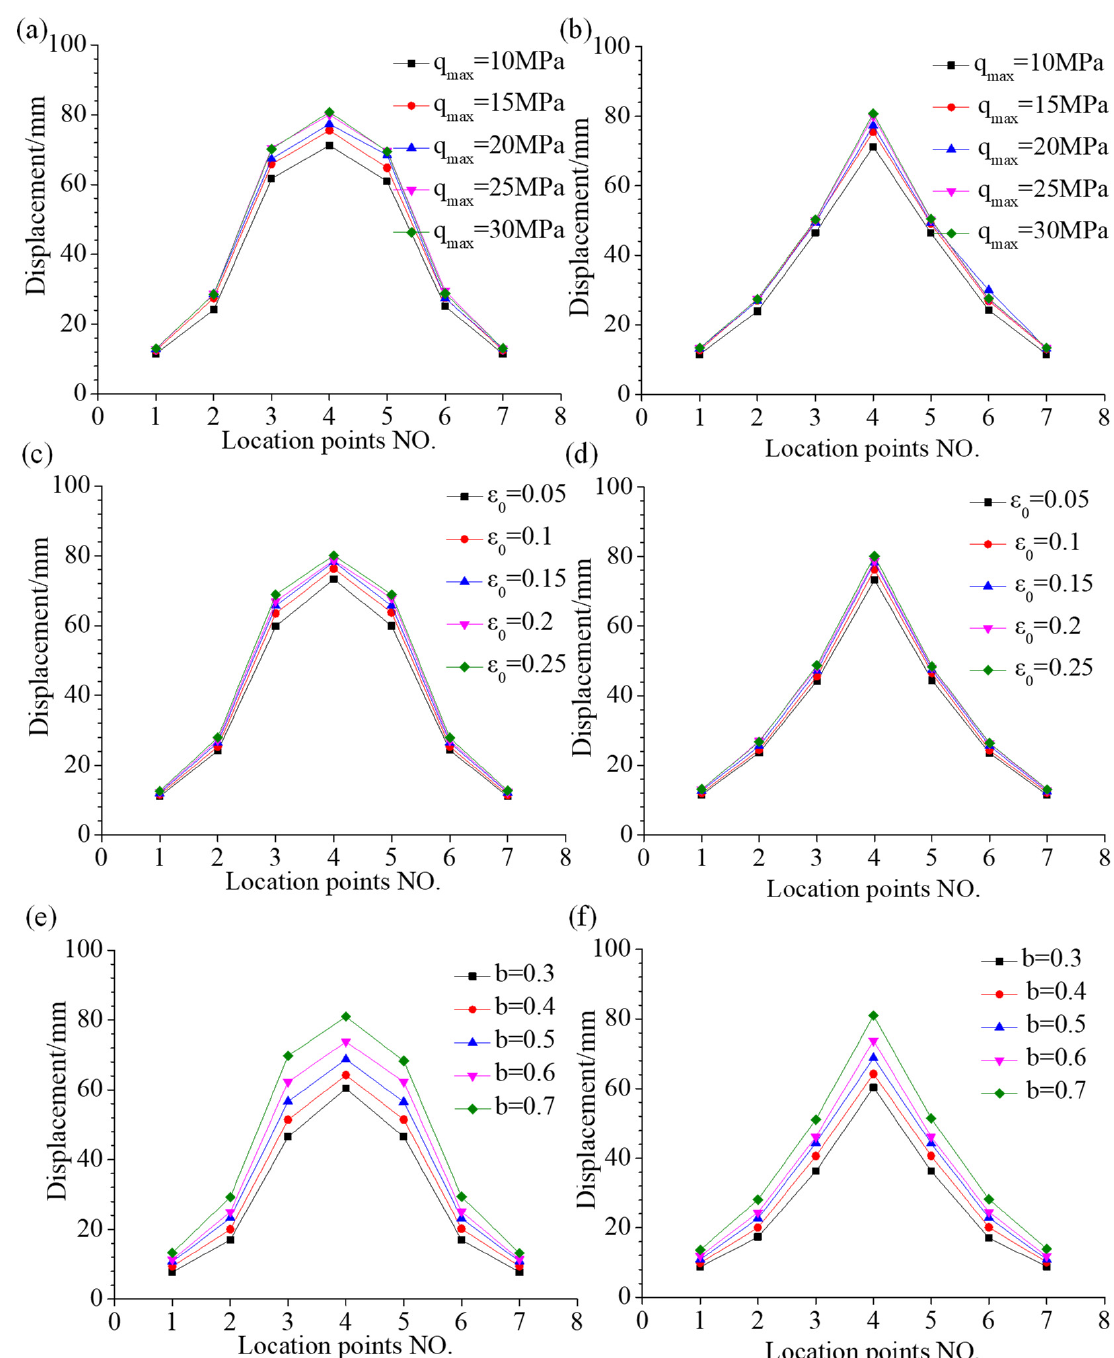
Figure 24. Comparison of deformations under different constitutive parameters: ( a ) Deformation of line LB 4 under different values of q max ; ( b ) Deformation of line LA 4 under different values of q max ; ( c ) Deformation of line LB 4 under different values of ε 0 ; ( d ) Deformation of line LA 4 under different values of ε 0 ; ( e ) Deformation of line LB 4 under different values of b ; ( f ) Deformation of line LA 4 under different values of b .